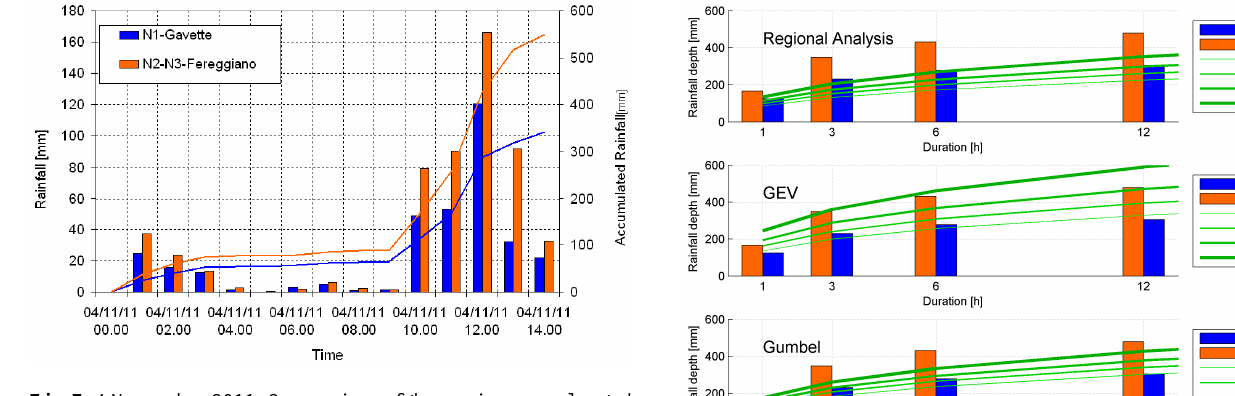
Fig. 7. 4 November 2011. Comparison of three rain gauges located Figure 7. 4 november 2011. Comparison of three rain gauges located inside or close to the 2 inside or close to the Fereggiano brook at an hourly resolution. On Fereggiano brook at the hourly resolution. On left Y axis hourly rainfall, on right Y axis 3 left y-axis hourly rainfall, on right y-axis accumulated rainfall. On accumulated rainfall. On x axis the UTC time is reported N1-Gavette, courtesy of the Liguria 4 x-axis, the UTC time is reported. N1-Gavette, courtesy of the Lig- Civil Protection Agency. N2-Fereggiano, courtesy of the Liguria Civil Protection Agency and 5 uria Civil Protection Agency; N2-Fereggiano, courtesy of the Lig- Municipality of Genova. N3-Fereggiano, courtesy of the Ligurian Association of 6 uria Civil Protection Agency and Municipality of Genova; and N3- Meteorology. 7 Fereggiano, courtesy of the Ligurian Association of Meteorology.